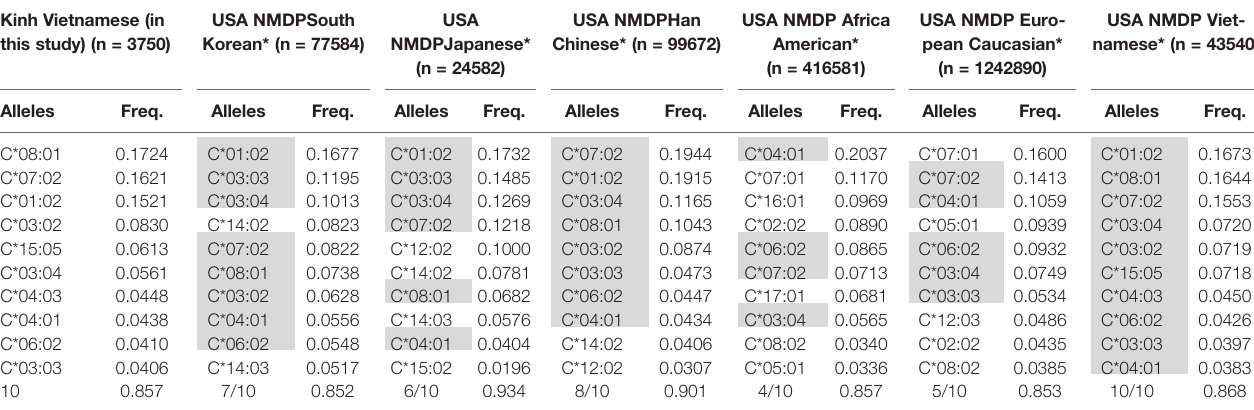
*From the allele frequency net, the grey background indicates common alleles shared between the Kinh Vietnamese and other populations.